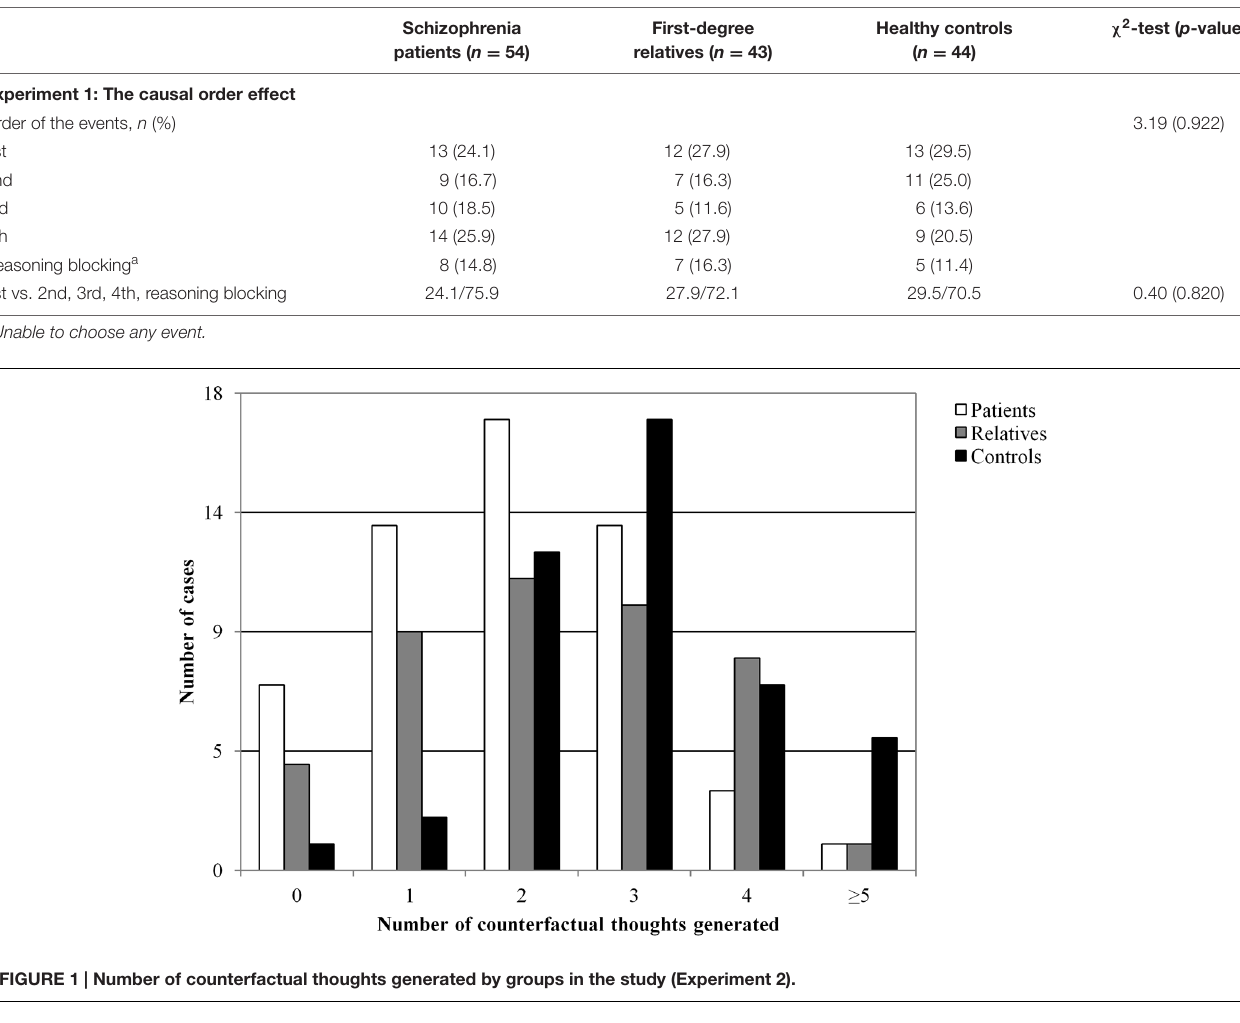
TABLE 4 | The causal order effect (Experiment 1): Descriptive and comparative analysis between groups.